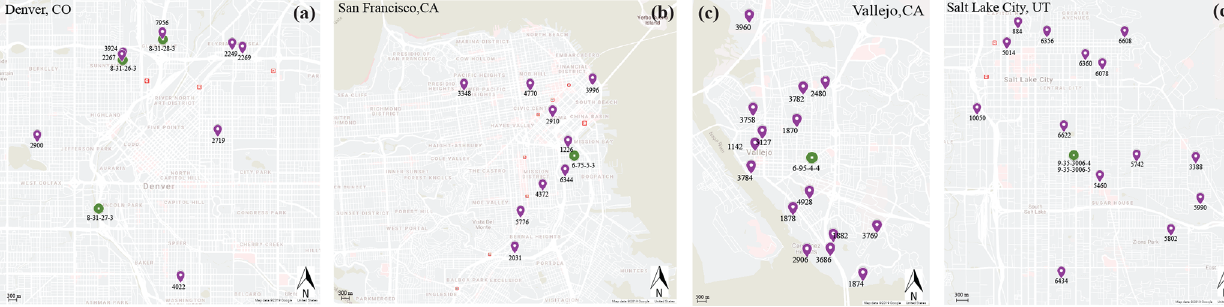
Figure 2. Maps of locations with AQMS and PA-II units; each map (a–d) represents a different region: (a) Denver, (b) San Francisco, (c) Vallejo, and Salt Lake City (d) . Maps created using © Google maps. AMQS units are represented by the green points, and the PA-II units are represented by the purple